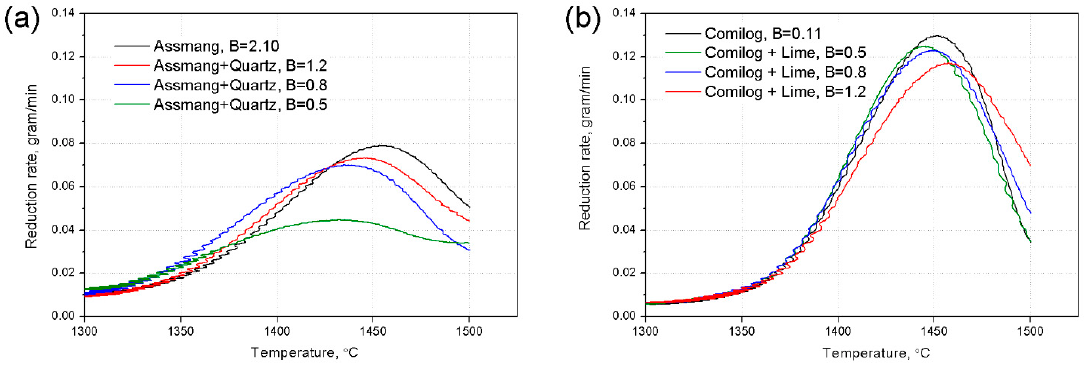
Figure 3. Calculated reduction rate versus temperature from all experiments. ( a ) Assmang series; ( b ) Comilog series.